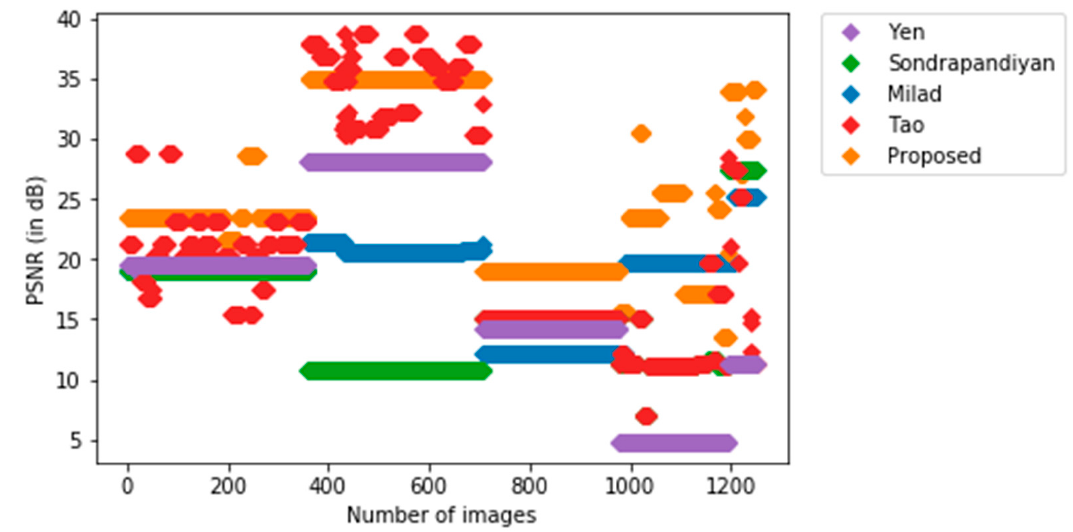
Figure 6. Comparison of the PSNR values for the five methods. Table 3. Average peak signal noise ratio (PSNR) (in dB) results for the five methods.